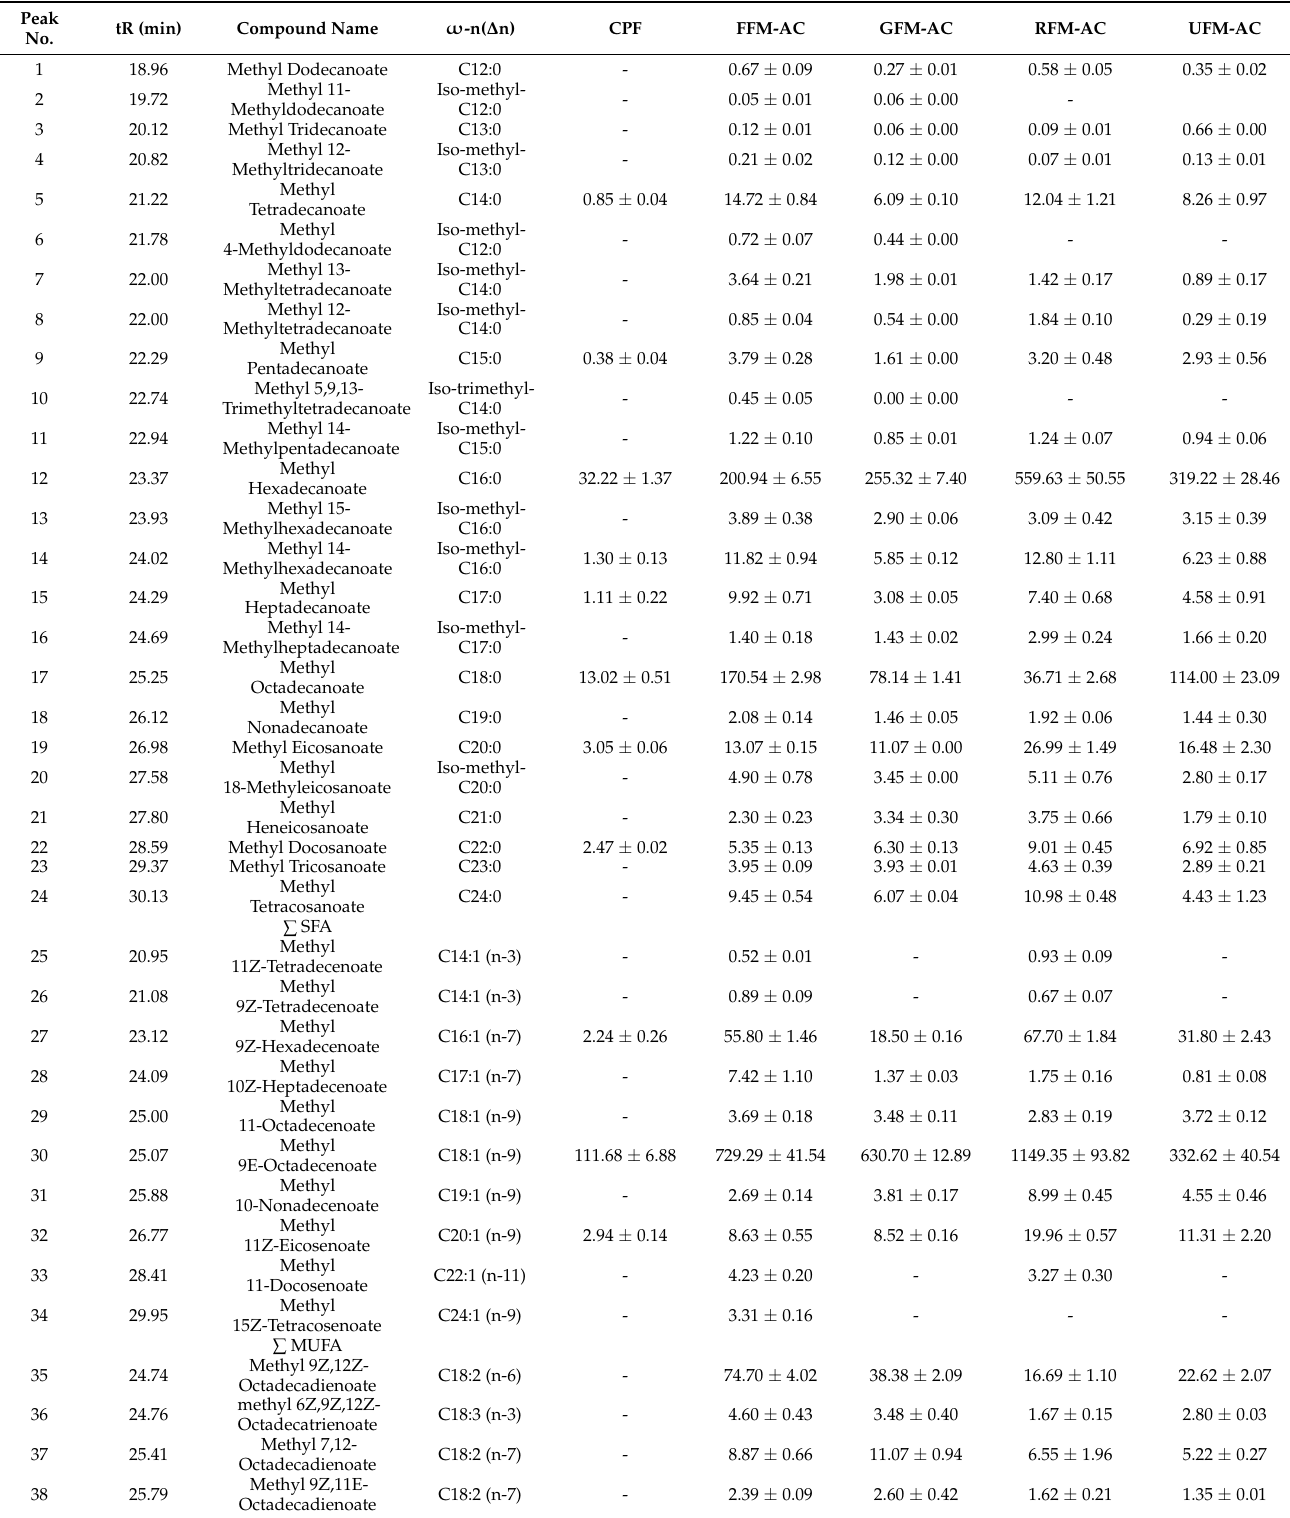
Table 2. Compositions of fatty acids ( µ g/g of oil) of porridge flour samples analysed using gas chromatography coupled with mass spectrometry